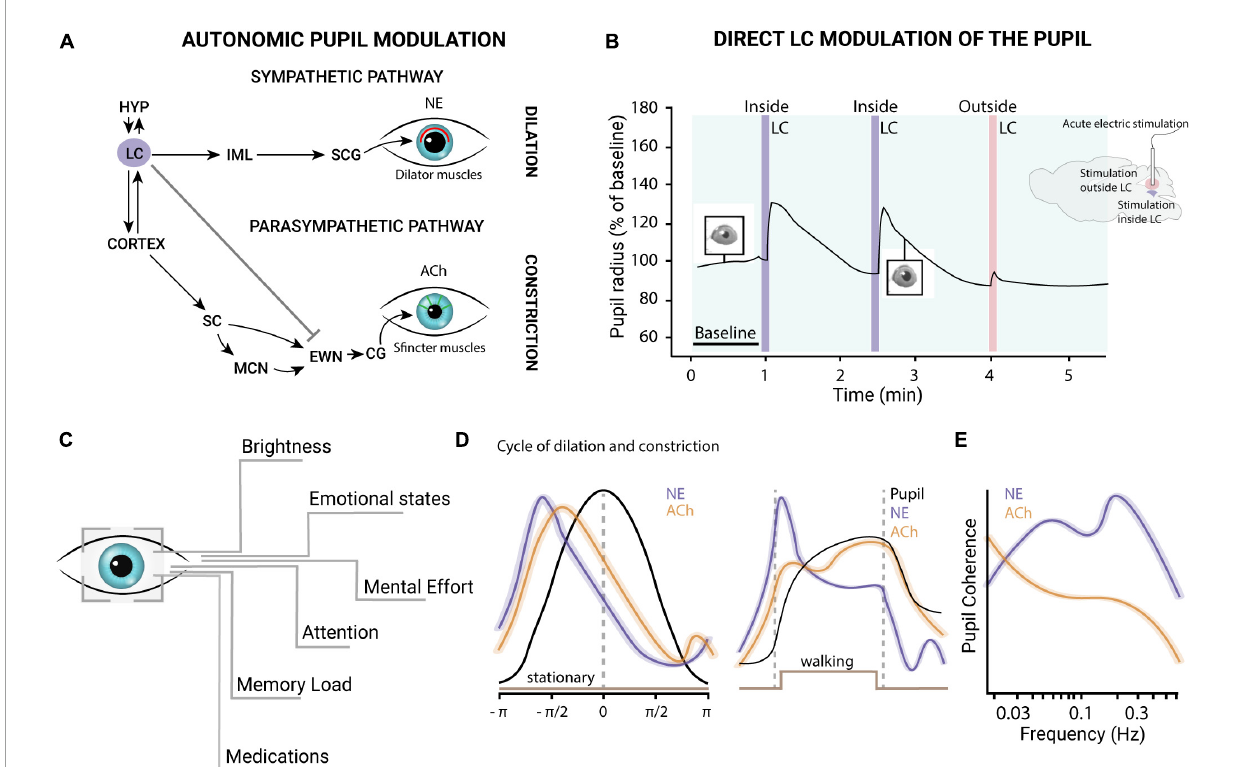
FIGURE2 (A) The pupil constriction and dilation pathways. The iris of the eye contains two muscles that control its size: the sphincter muscle and the dilator muscle. The size of the iris is regulated by two interconnected neural pathways: the parasympathetic constriction pathway and the sympathetic dilation pathway. The parasympathetic constriction pathway originates in the EWN, which via cholinergic preganglionic motoneurons, sends its axons to synapse on the sphincter muscle. This pathway causes sphincter muscle contraction, leading to constriction of the pupil. The sympathetic dilation pathway originates in the SCG and sends axons to synapse on the dilator muscle. This pathway causes the dilator muscle relaxation, leading to pupil dilation. The LC plays a key role in regulating the sympathetic nervous system, including the sympathetic dilation pathway that controls pupil size. The LC is responsible for releasing the neurotransmitter NE, which acts on the dilator muscle and regulates pupil size. Activation of the LC leads to the dilation of the pupil, and inhibition of the LC leads to constriction of the pupil. Additionally, studies have shown that the LC-NE system regulates the pupillary light reflex, which is the automatic response of the pupil to changes in light intensity. (B) LC-pupil relationship. The acute electric stimulation of the LC is able to evoke pupillary dilations in mice. Redrawn from Privitera et al. (2021). (C) Exogenous factors influencing pupil size. (D) The left panel shows ACh (orange) and NE (violet) dynamics during the dilation (values < 0) and constriction (values > 0) phases in the absence of locomotion. The right panel illustrates NE and ACh activity during locomotion onset and offset. NE activity levels were higher and had a shorter latency than ACh activity preceding the peak of dilation. These findings suggest that both neuromodulatory systems contribute to regulating pupil size changes during quiet wakefulness, with NE playing a more prominent role in rapid and transient pupil responses. During locomotion, phasic noradrenergic axonal activity (violet) is closely linked to rapid pupil dilations, while sustained cholinergic axonal activity (orange) is associated with longer-lasting dilations (left). This figure is adapted from Reimer et al. (2016). (E) Coherence of NE and ACh in pupillary oscillations: NE levels display coherence with pupillary fluctuations across a wide frequency range. In contrast, ACh exhibits coherence primarily at lower frequencies, indicating distinct roles of the two neuromodulatory systems in the initiation and maintenance at different time scales. This figure is adapted from Reimer et al. (2016). HYP, hypothalamus; LC, locus coeruleus; SC, superior colliculus; MCN, mesencephalic cuneiform nucleus; EWN, Edinger-Westphal nucleus; CG, ciliary ganglion; ACh, acetylcholine; IML, intermediolateral cell column of the spinal cord; SCG, superior cervical ganglion; NE,